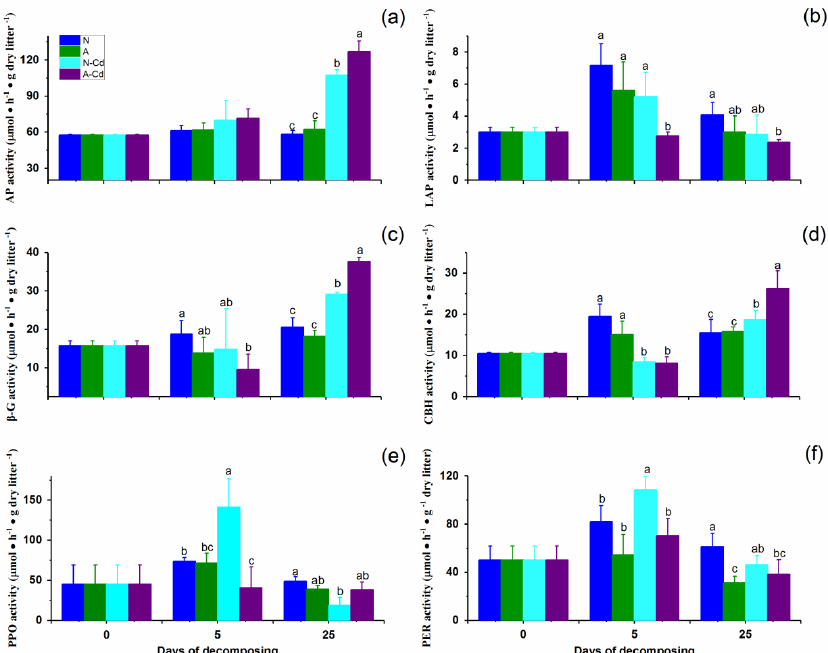
Figure 4. Changes in the enzymatic activities of leaf litter during the decomposition process. Legends: ( a ) acid phosphatase, AP; ( b ) leucine-aminopeptidase, LAP; ( c ) β-glucosidase, β-G; ( d ) cellobiohydrolase, CBH; ( e ) polyphenol oxidase, PPO; ( f ) phenol oxidase, PER; N: Natural lighting simulation group; A: artificial light at night simulation group. Di ff erent letters denote a significant di ff erence between treatments at the same sampling time ( p < 0.05; Tukey (cid:48) s test).